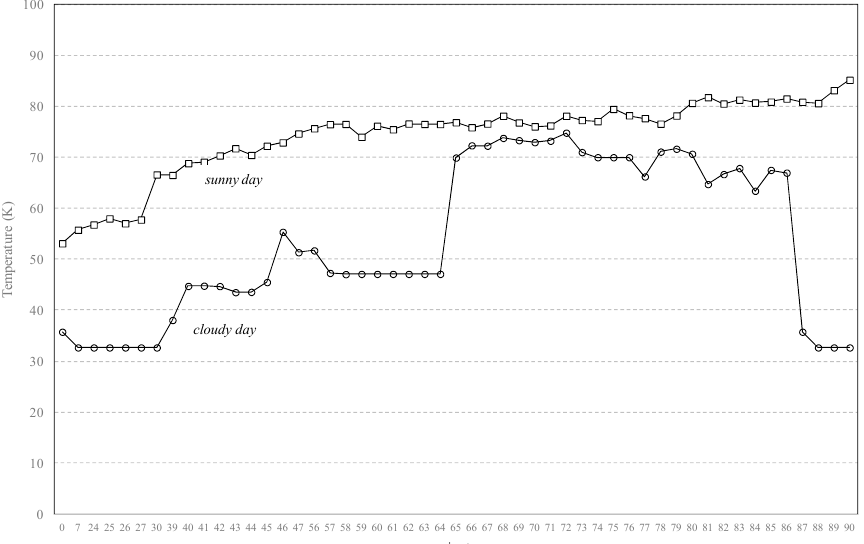
Figure 11. Experimental trend of the fluid temperature for a sunny day and a cloudy day.